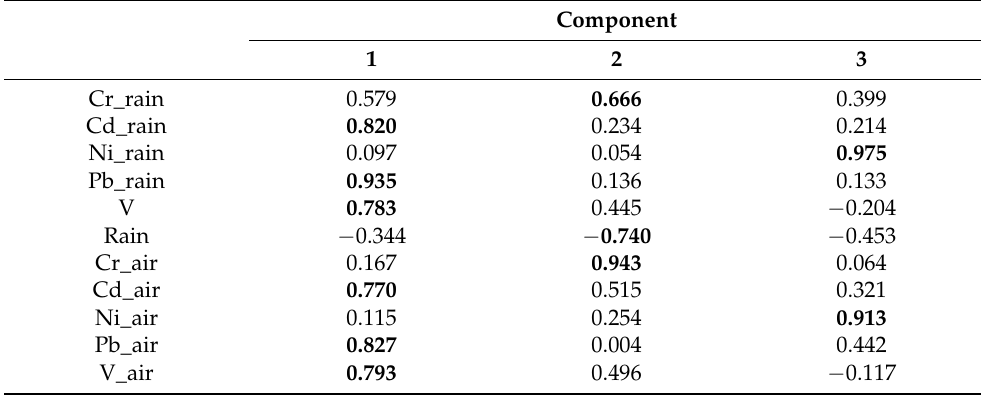
Principal Component Analysis; rotation method: Varimax with Kaiser